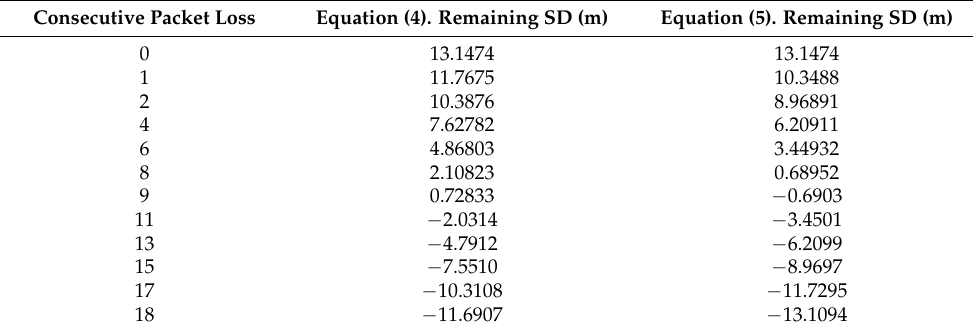
Table 5. Thirty miles per hour (48.27 km/h) remaining stopping distance. Consecutive Packet Loss Equation (4). Remaining SD (m) Equation (5). Remaining SD